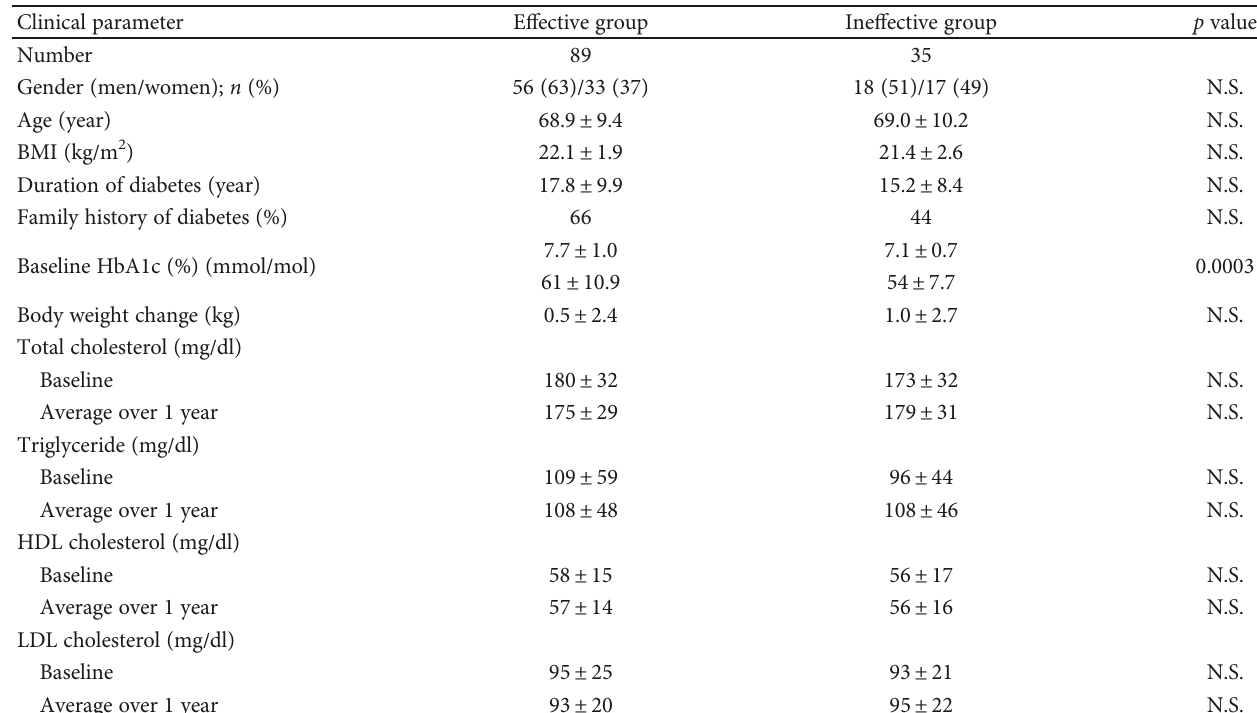
Table 3: Comparison of clinical background between the e ff ective group and ine ff ective group in nonobese subjects with type 2 diabetes (BMI < 25kg/m 2 ).